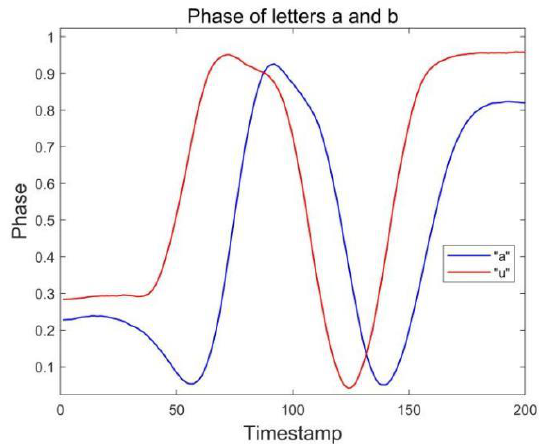
Figure 2. Phase of letters a and u collected by antenna #1.